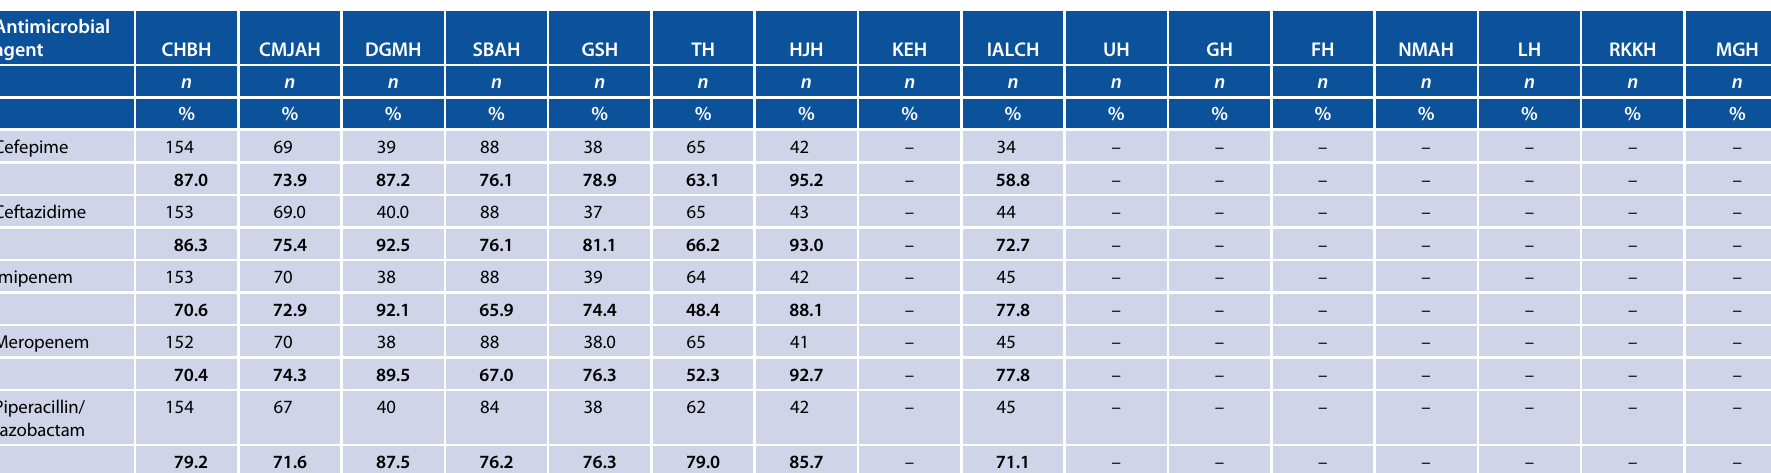
Gentamicin Imipenem Meropenem Tigecycline